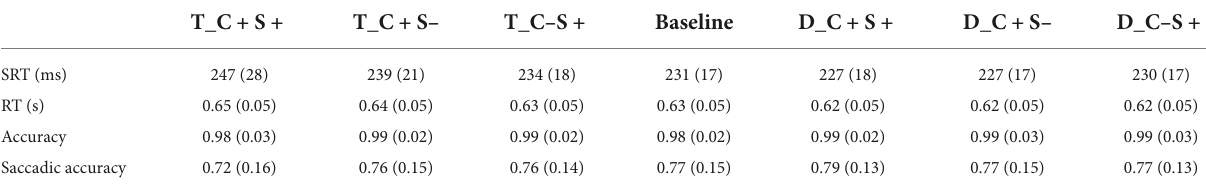
TABLE 4 Mean saccadic reaction time (ms) and reaction time (s) and accuracy and saccadic accuracy for all condition of Exp. 3A (standard deviations are within